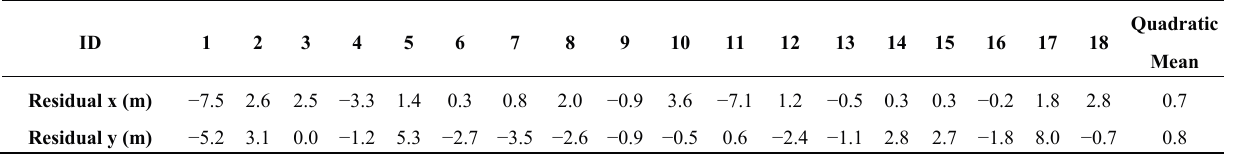
Table 2. Residuals of the first degree polynomial transformation applied to the historical raster map based on the GPS